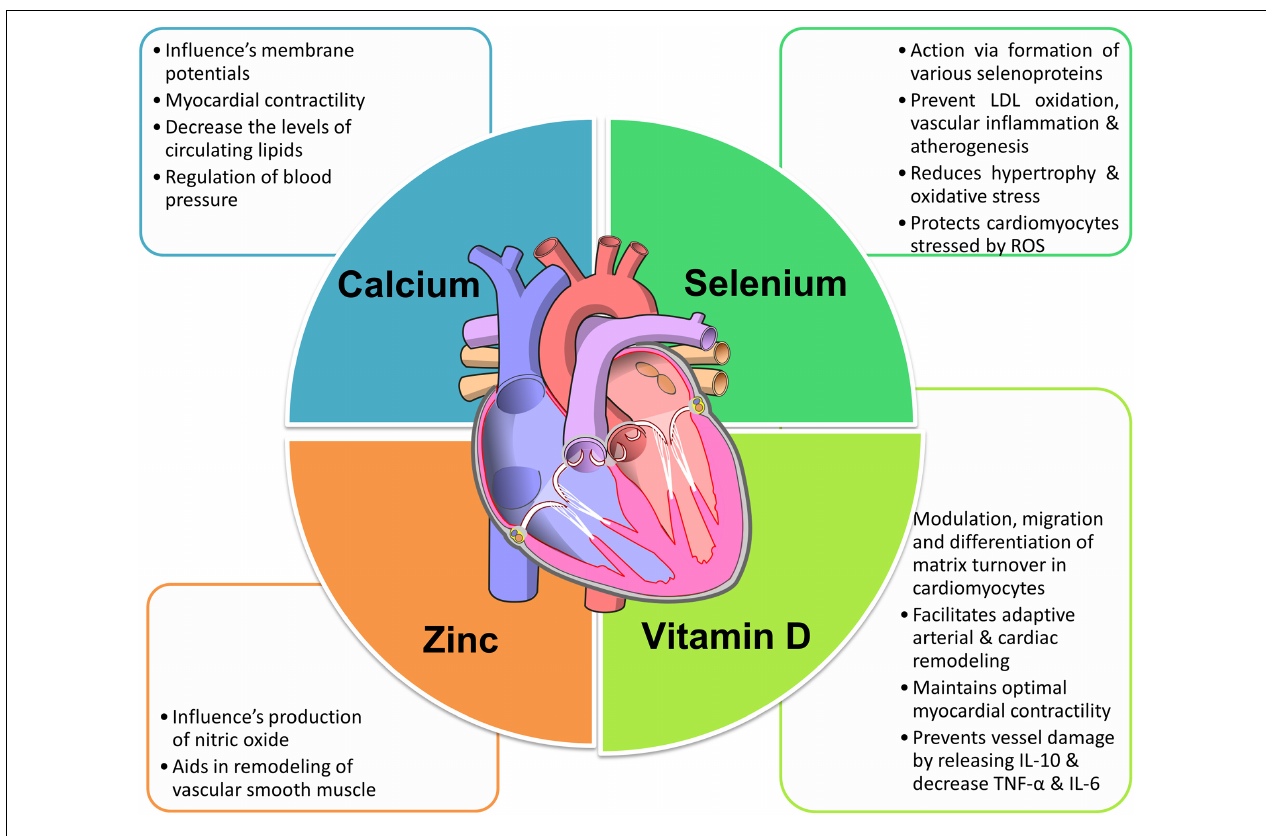
FIGURE 1 | The role of micronutrients in cardiovascular health. Image is adapted from https://commons.wikimedia.org/wiki/File:Diagram_of_the_human_heart_(no_labels).svg (Stenemo,